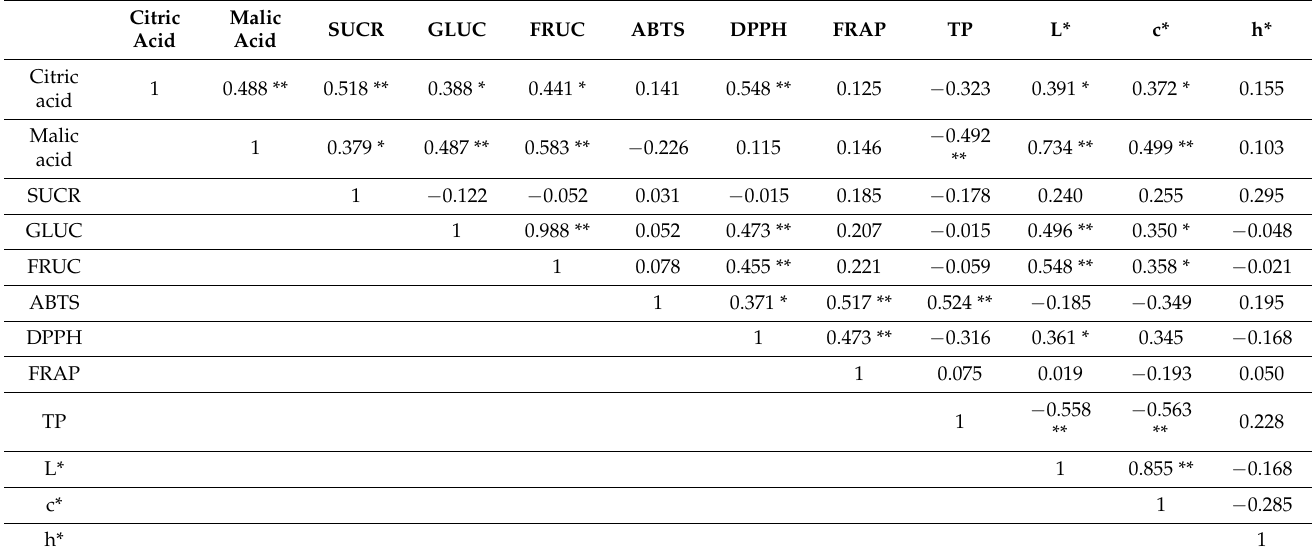
Table 6. Matrix of coefficient correlations between all variables